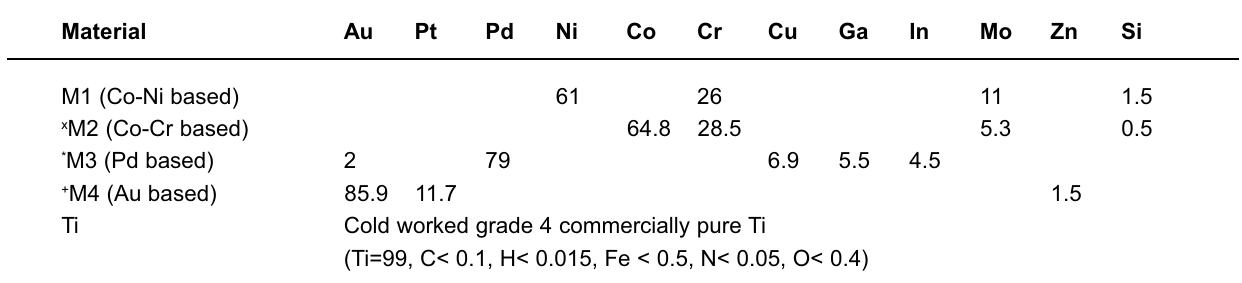
TABLE 1- Chemical composition of materials used as weight